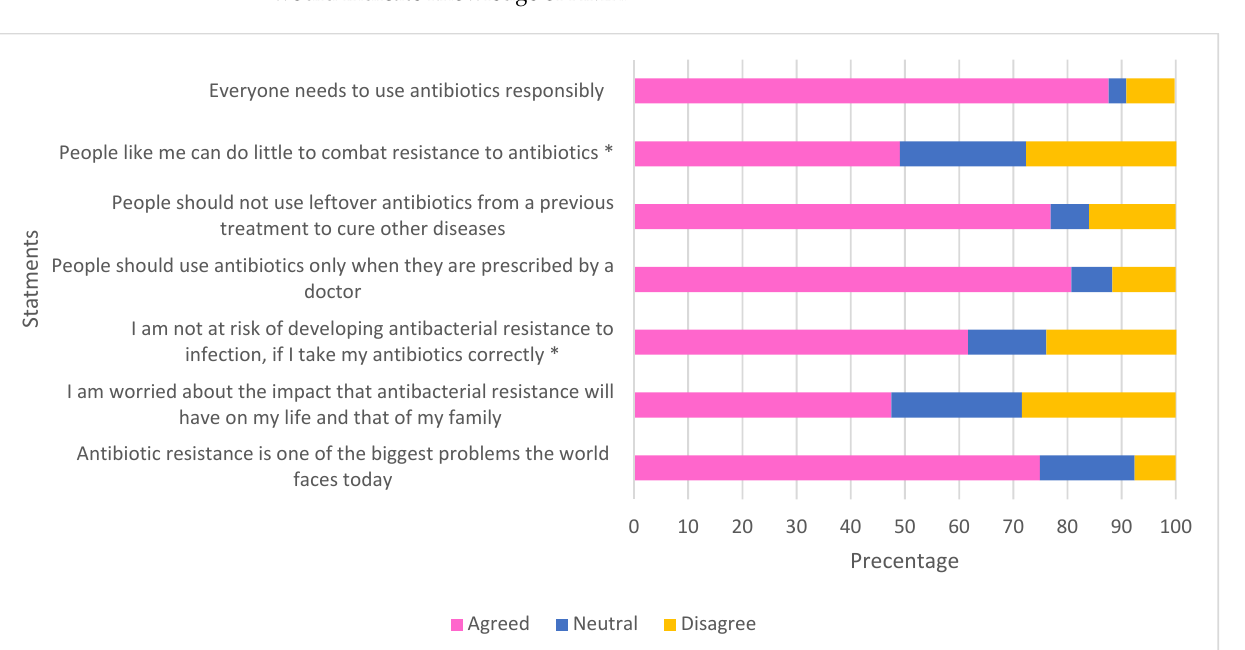
Figure 4. Urban respondents’ knowledge of AMR. Answers of “true” indicate good understanding of AMR, apart from for negatively worded statements (highlighted by *) where an answer of “false” would indicate knowledge of AMR.